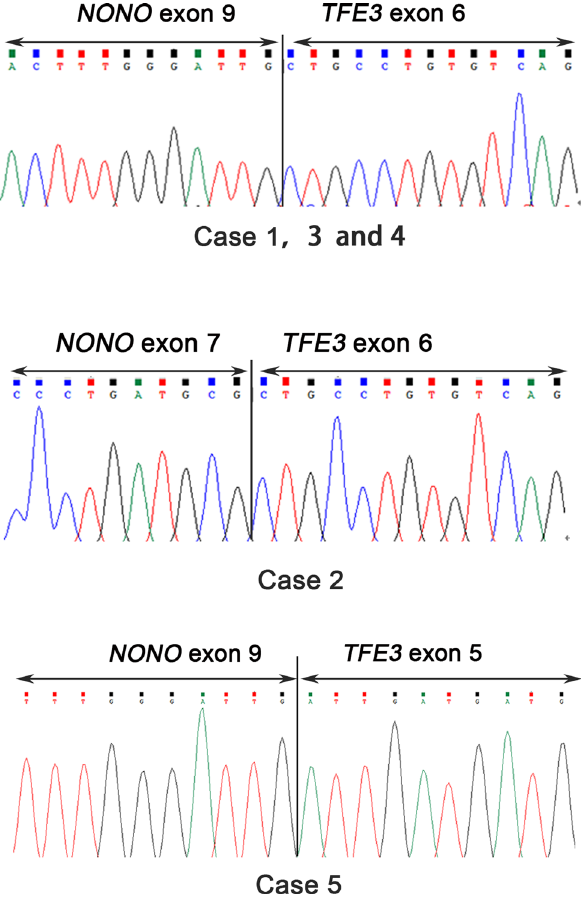
Figure 6. The NONO-TFE3 fusion gene patterns among five cases: case 1, 3 and 4 had a fusion pattern between exon 9 of NONO and exon 6 of TFE3 , cases 2 had a fusion pattern between exon 7 of NONO and exon 6 of TFE3 , while case 5 had a fusion pattern between exon 9 of NONO and exon 5 of TFE3